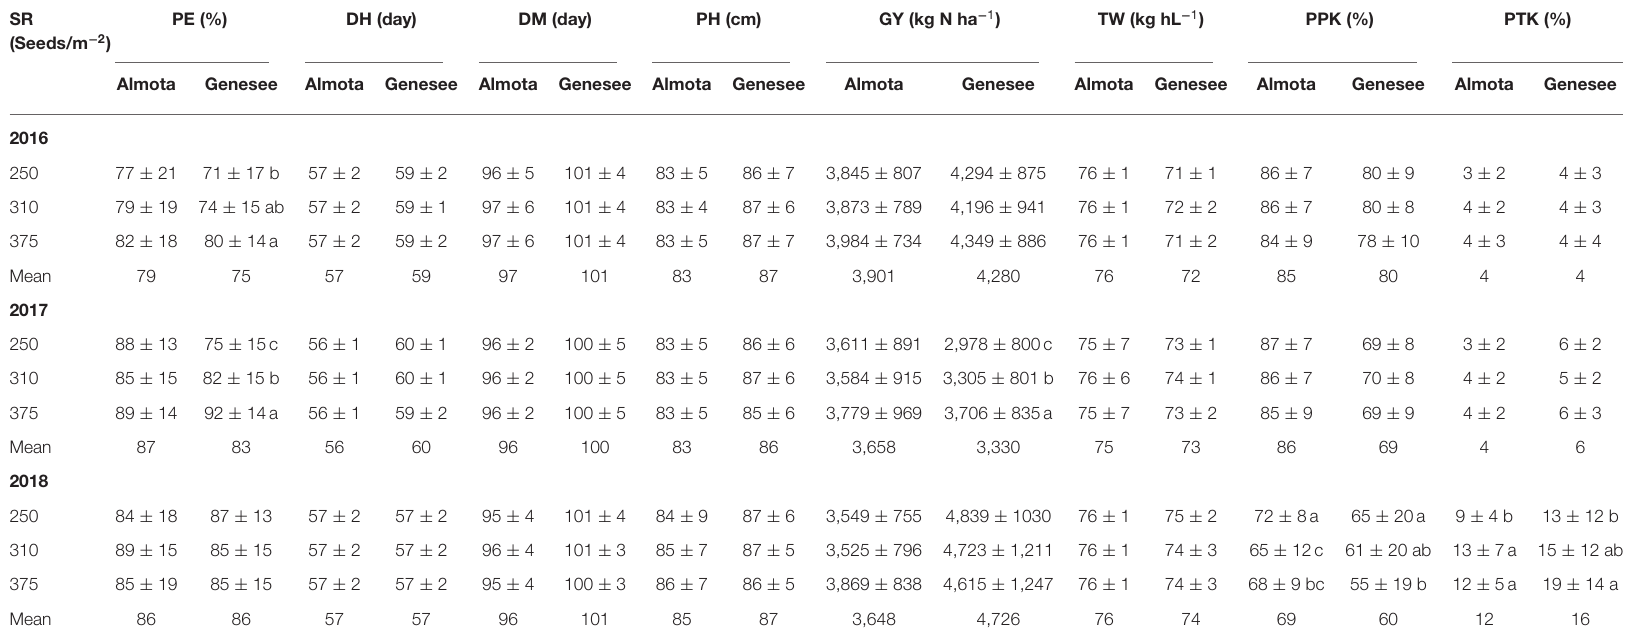
TABLE 10 | Mean data across six site-years for the effect of seeding rates on agronomic traits. SR (Seeds/m − 2